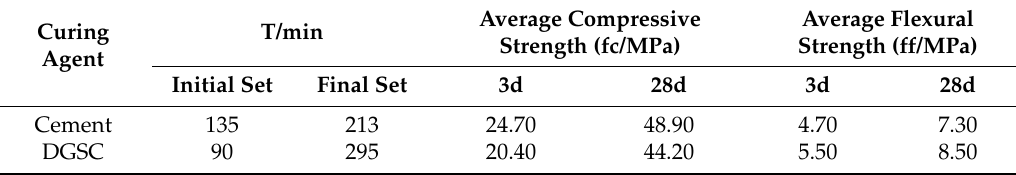
Table 2. Physical and mechanical properties of the cement and